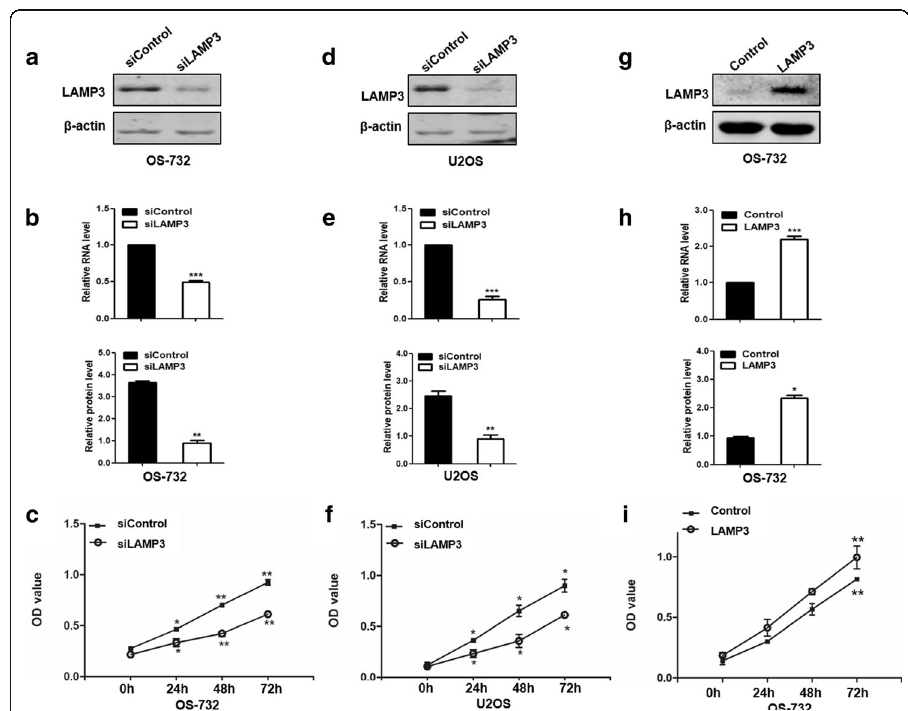
Fig. 1 LAMP3 regulated cell viability in osteosarcoma (OS) cells. a , b , d and e – Western blots showing the efficiency of LAMP3 knockdown in OS-732 ( a , b ) or U2OS ( d , e ) cells at the mRNA ( a , d ) and protein ( b , e ) levels. β -actin served as the loading control. g and h – Western blots showing the efficiency of LAMP3 overexpression. c , f and i – MTT assay results showing that OS cell viability decreased after the inhibition of LAMP3 (C) and increased following overexpression of LAMP3 ( f ) compared with the control ( i ). * p < 0.05, ** p < 0.01, *** p < 0.001, n =